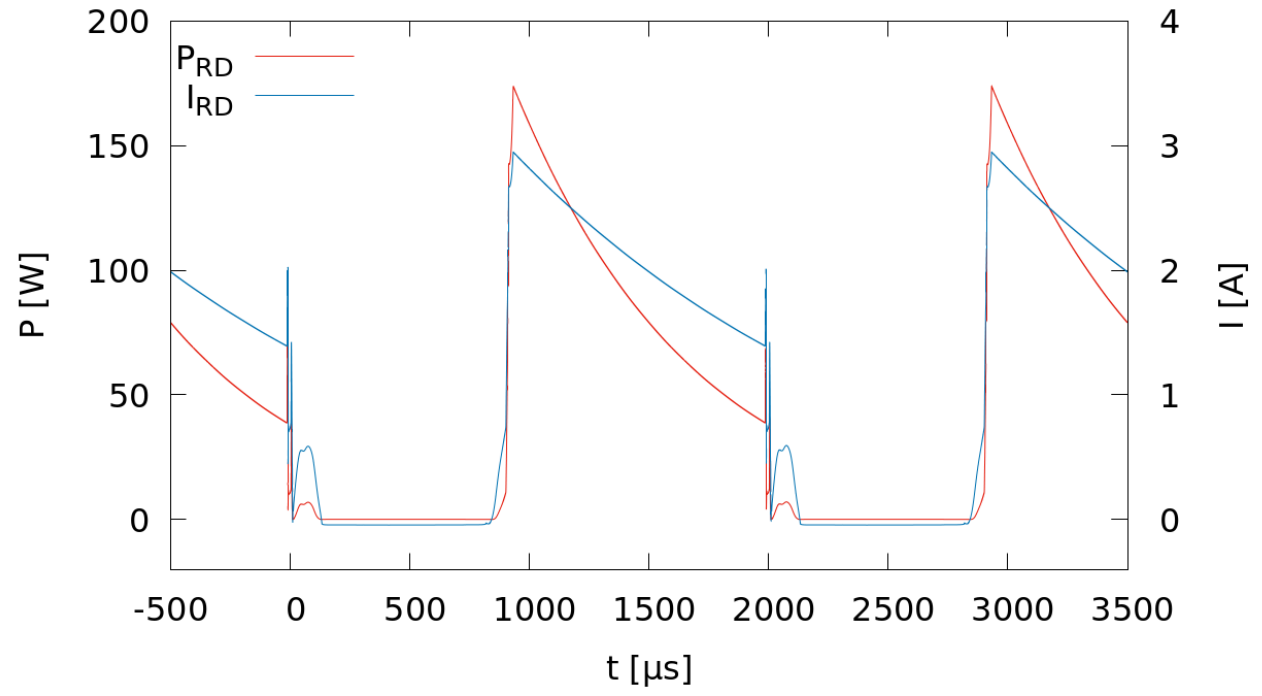
Figure 11. Losses at the damping resistor R D (R3 in Figure 3): Power P RD and current through R D (I RD ).